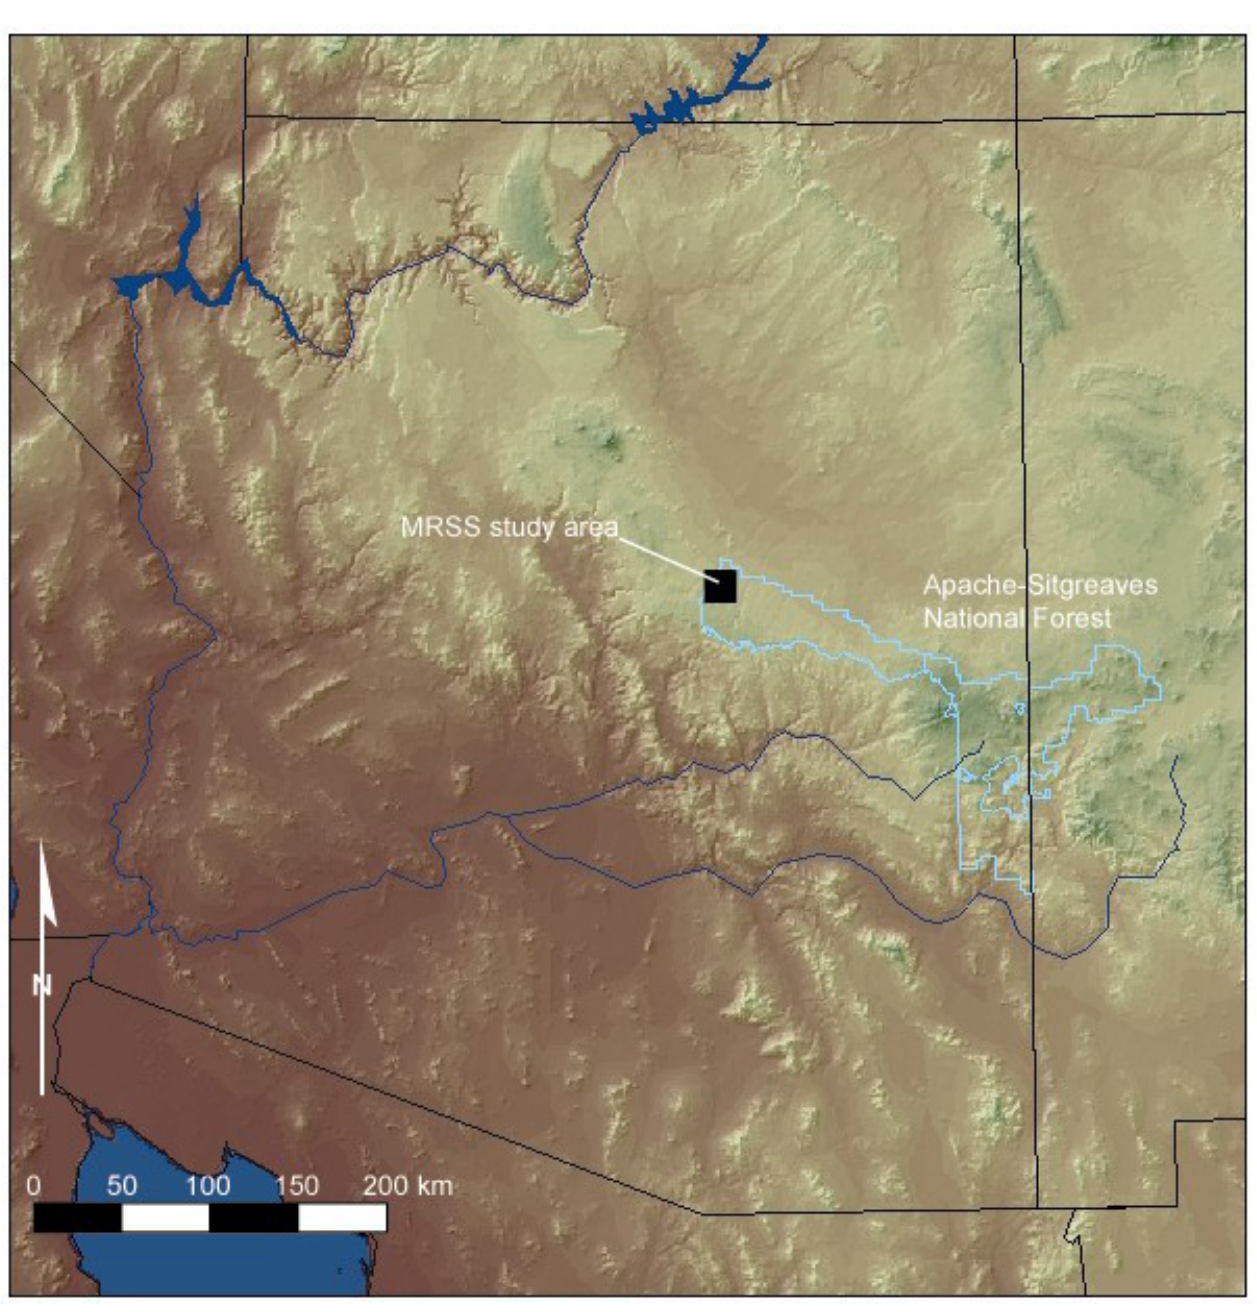
Fig. 2. Study area of the Mogollon Rim Small-site Survey in northern